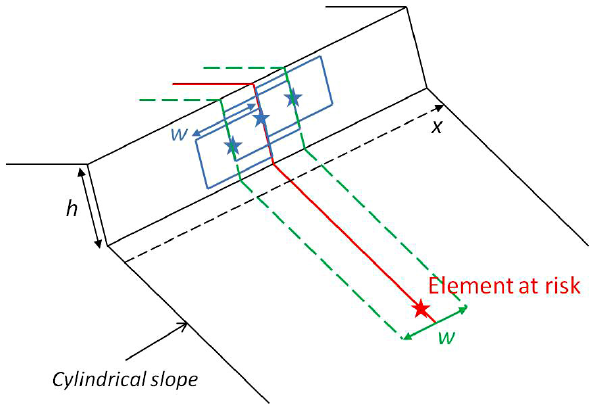
Fig. 1. Cylindrical slope with rock compartments having the same width w